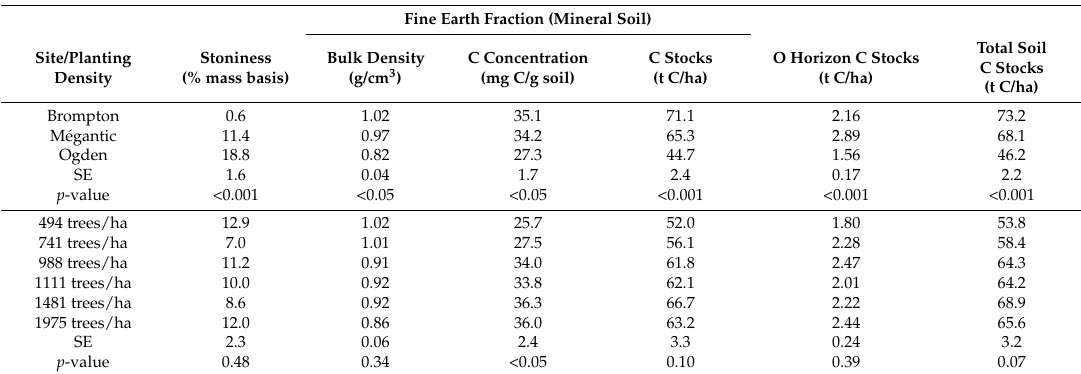
Table 6. Site and Planting density effects on soil stoniness, bulk density, carbon stocks and concentration in 14 year-old hybrid poplar plantations (0–20 cm layer).